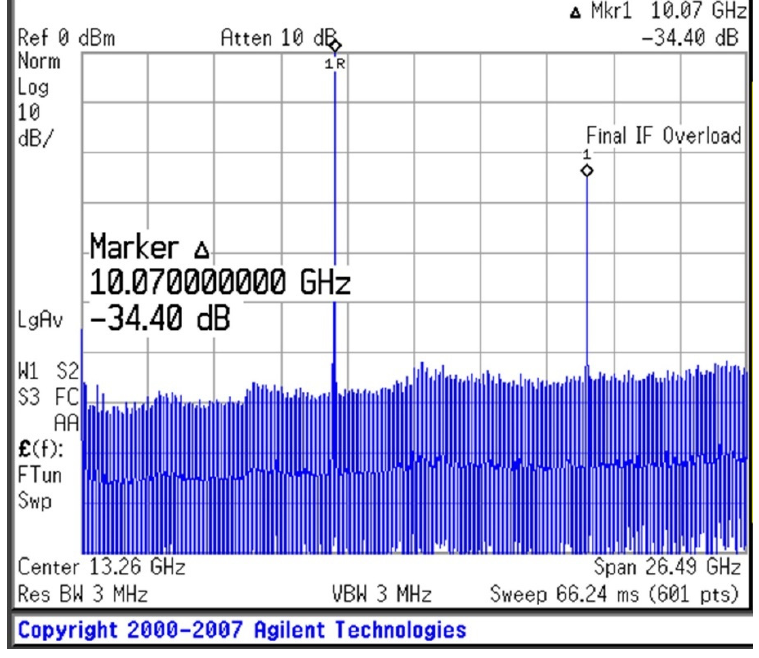
Figure 8. Experimental results for the designed oscillator (V DS = 3 V, I D = 40 mA): ( a ) phase noise, ( b ) output power, and ( c ) second harmonic suppression. Table 3. Comparison between the parameters of the proposed oscillator and those of oscillators developed in previous studies.